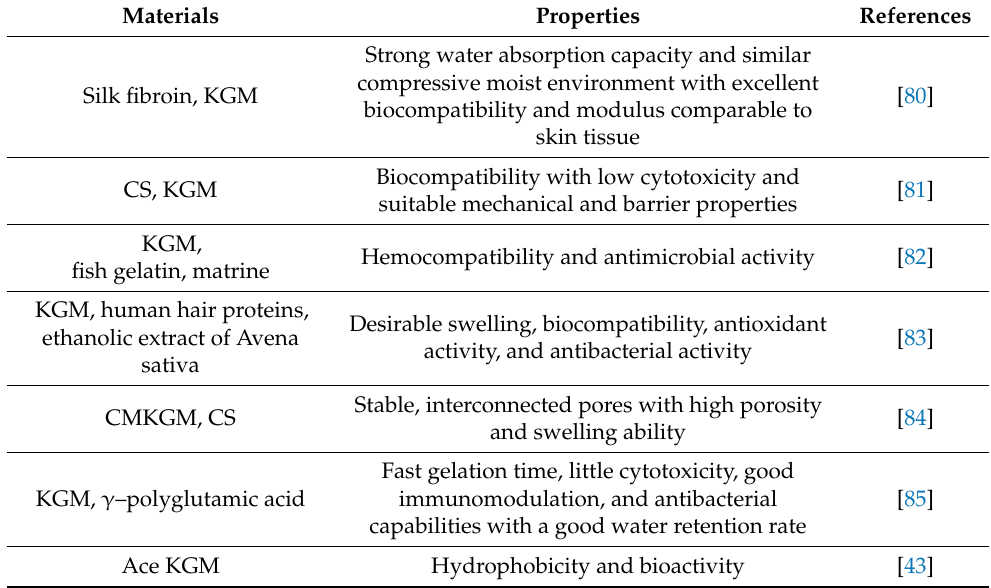
Table 2. KGM as wound dressing